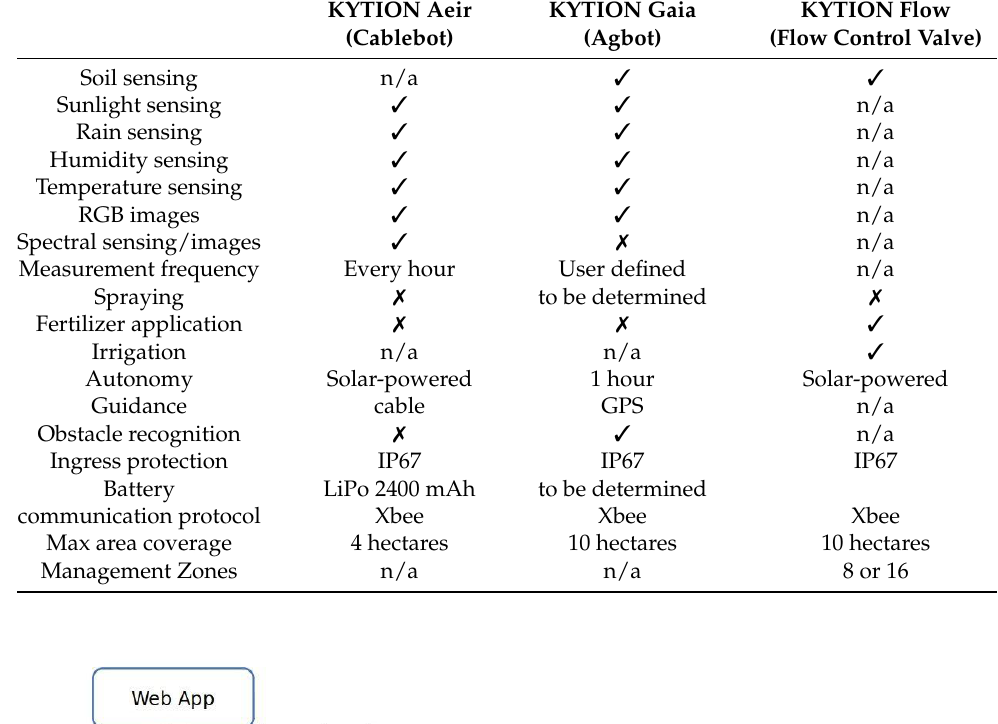
Table 3. Technical Characteristics of the 3DS System.